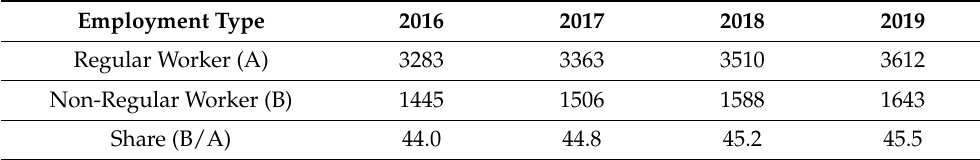
Table 2. Monthly gross income by employment unit: KRW 1000, %.